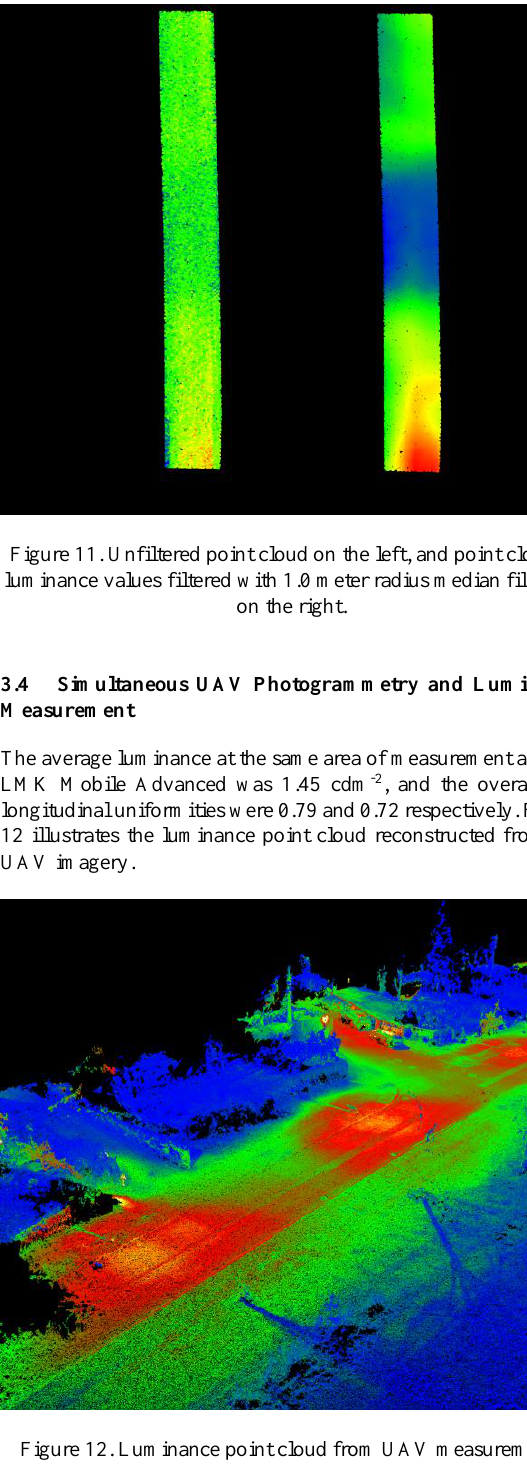
Table 1. The properties of selected luminance mapping